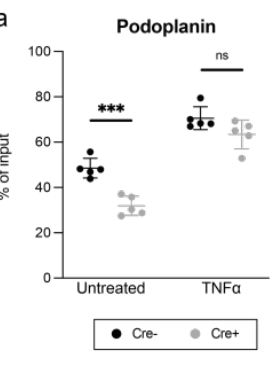
Figure 4. Podoplanin, CD200, and BST2 impact macrophage adhesion to primary LN LECs. ( a – d ) In vitro adhesion of macrophages to a LN LEC monolayer after podoplanin deletion ( a ) or antibody- mediated blockade of CD200 ( b ), BST2 ( c ), or tenascin ( d ) measured by flow cytometry. One repre- sentative experiment (of 3) is shown with the number of adhered macrophages as percentage of input ( N = 4 – 5), mean, and SD. Ns p ≥ 0.05, * p < 0.05, ** p < 0.01, *** p < 0.001, unpaired t -test.